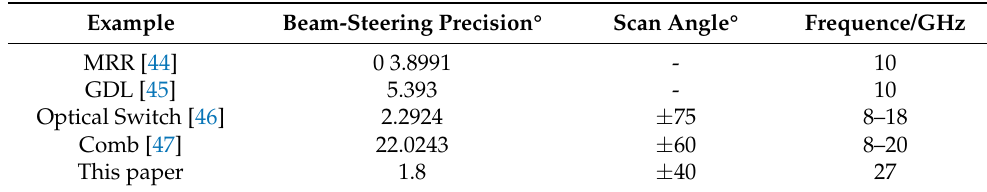
Table 2. Comparison between different OTTD and